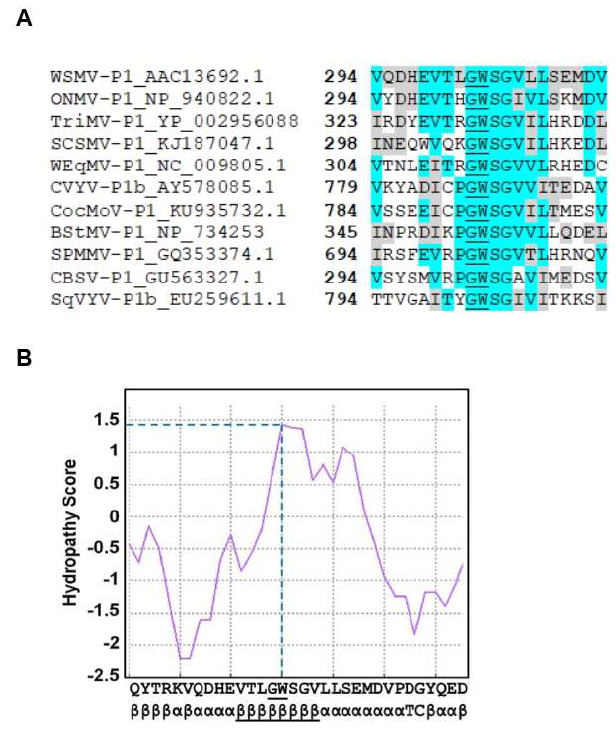
Figure 5. WSMV P1 harbors a conserved GW motif. ( A ) Multiple sequence alignment of GW containing AGO interacting domains of P1-like proteins of Wheat streak mosaic tritimovirus (WSMV), Oat necrotic mottle tritimovirus (ONMV), Triticum mosaic poacevirus (TriMV), Sugarcane streak mosaic poacevirus (SCSMV), Wheat eqlid mosaic tritimovirus (WEqMV), Cucumber vein yellowing ipomovirus (CVYV), Coccinia mottle ipomovirus (CocMoV), Brome streak mosaic tritimovirus (BStMV), Sweet potato mild mottle ipomovirus (SPMMV), Cassava brown streak ipomovirus (CBSV), and Squash vein yellowing ipomovirus (SqVYV). GenBank accession number for each sequence was indicated in the label of corresponding sequence. The numbers in bold indicate the position of first residue of each sequence within its cistron. A GW dipeptide motif was underlined within each sequence. Blocks highlighted in turquoise indicate similar amino acids with high sequence conservation, while blocks highlighted in gray indicate amino acids with similar biochemical properties. ( B ) Hydropathy analysis and secondary structure prediction of partial sequence of WSMV P1 (aa 289–320) indicates high accessibility of GW dipeptide in the cellular environment. GW dipeptide and its whole β -sheet were underlined to indicate their relative positions in the